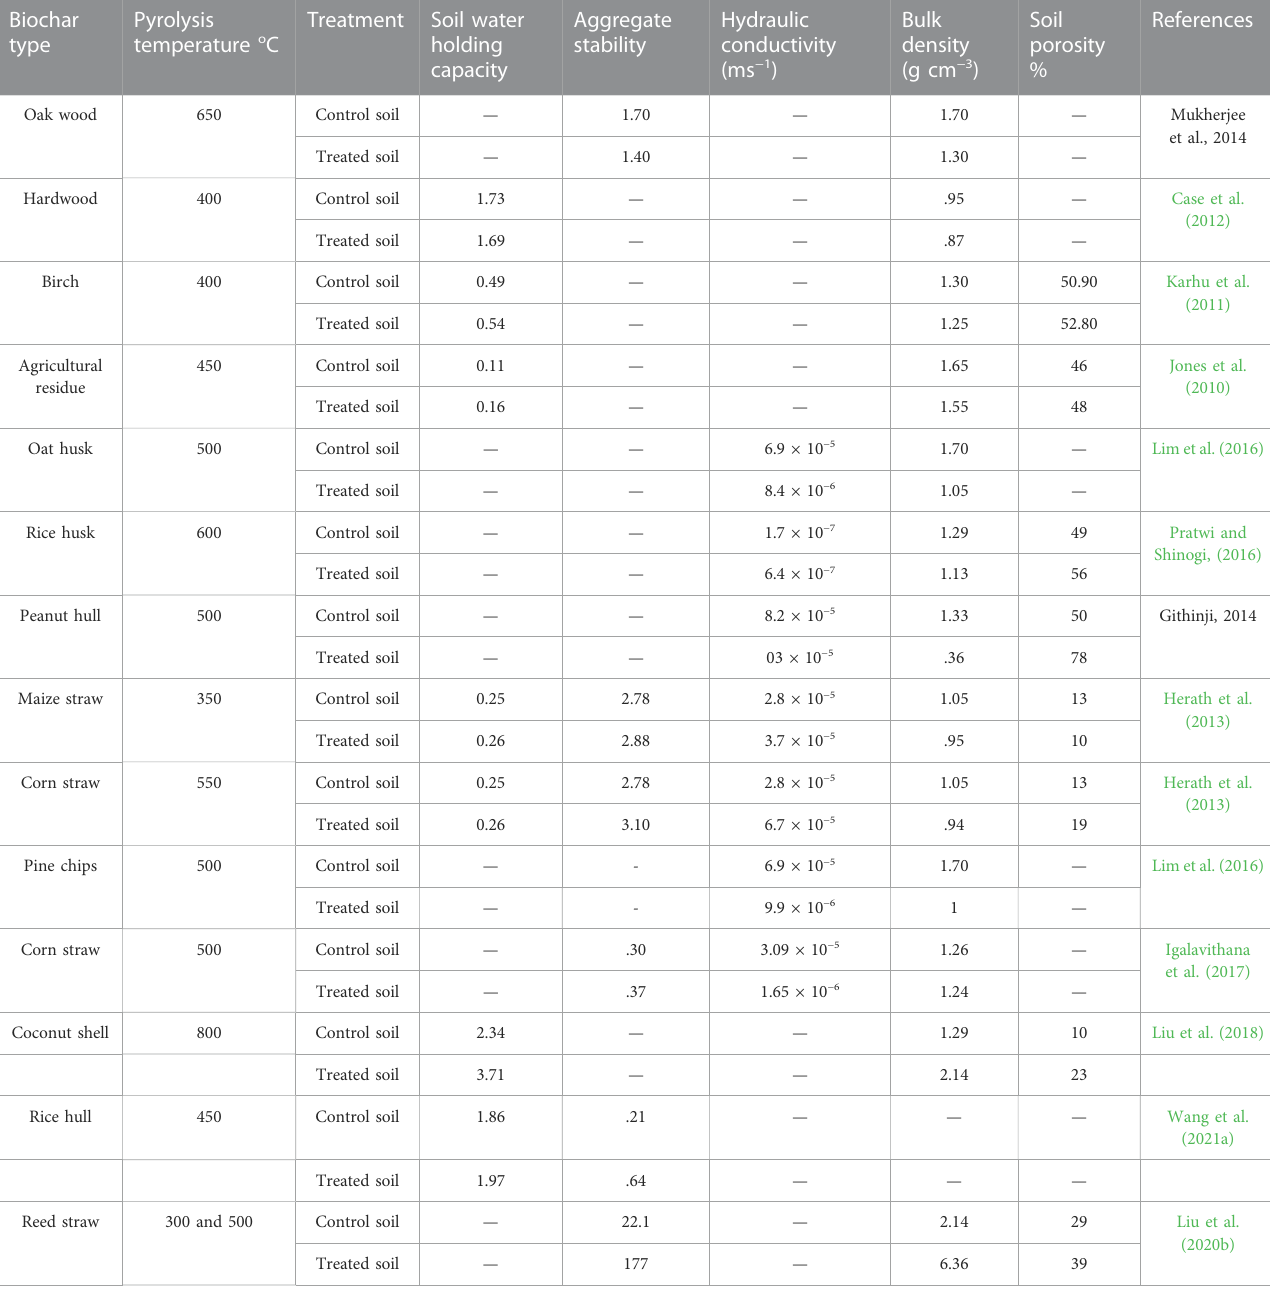
TABLE 1 Effect of biochar addition on the soil physical attributes. Biochar type